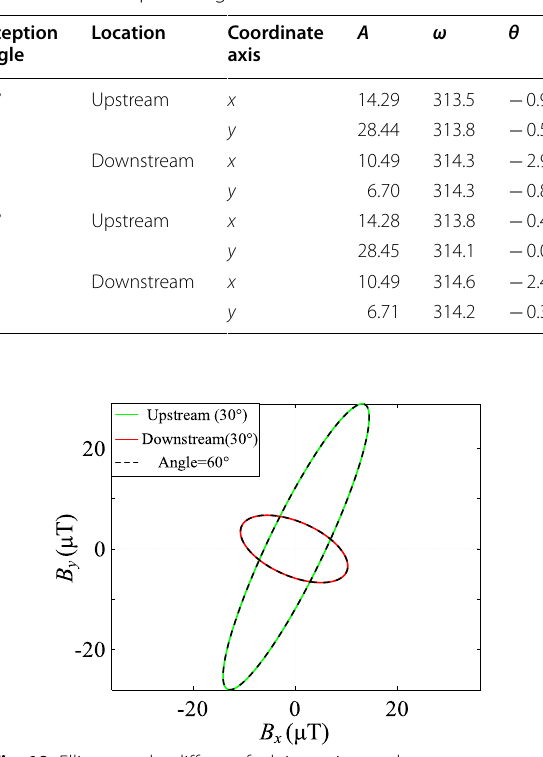
Table 6 Parameters of magnetic field sine functions